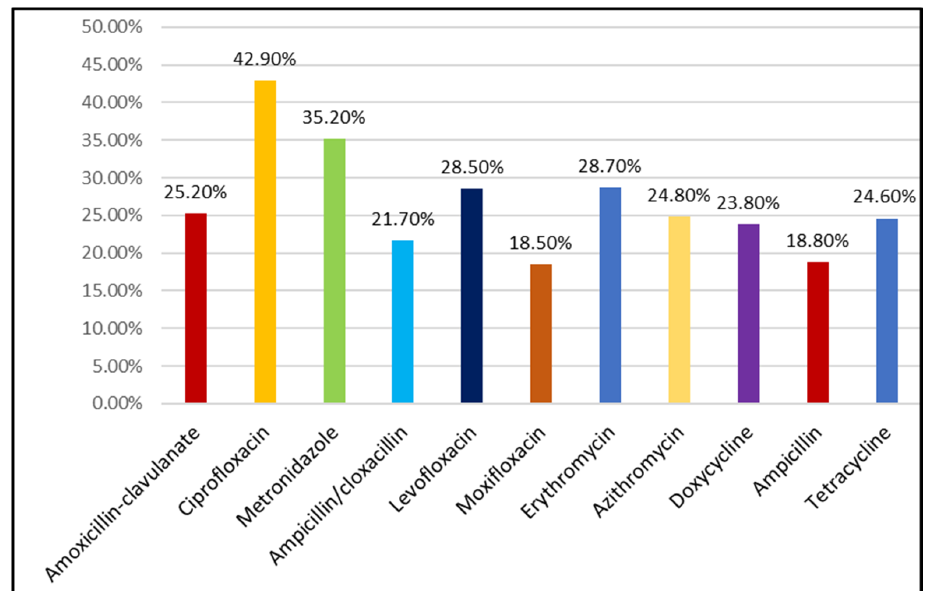
Figure 2. Most commonly used antibiotics for SMA in the study.